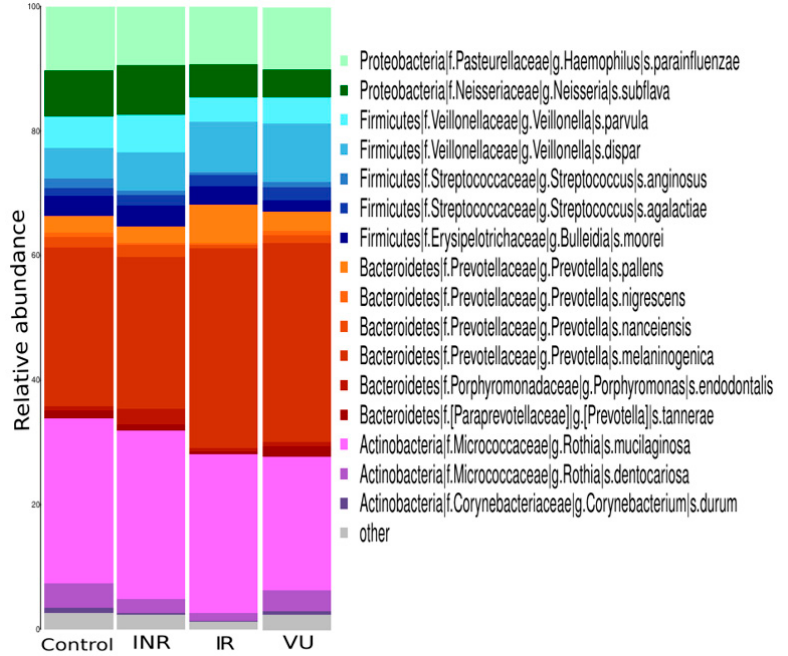
Figure 1. Oral microbiota composition in HIV-infected groups and controls. Species distribution of the salivary microbiota in each group. INR, immunological antiretroviral therapy (ART) non-responders; IR, immunological ART responders; VU, viremic untreated.